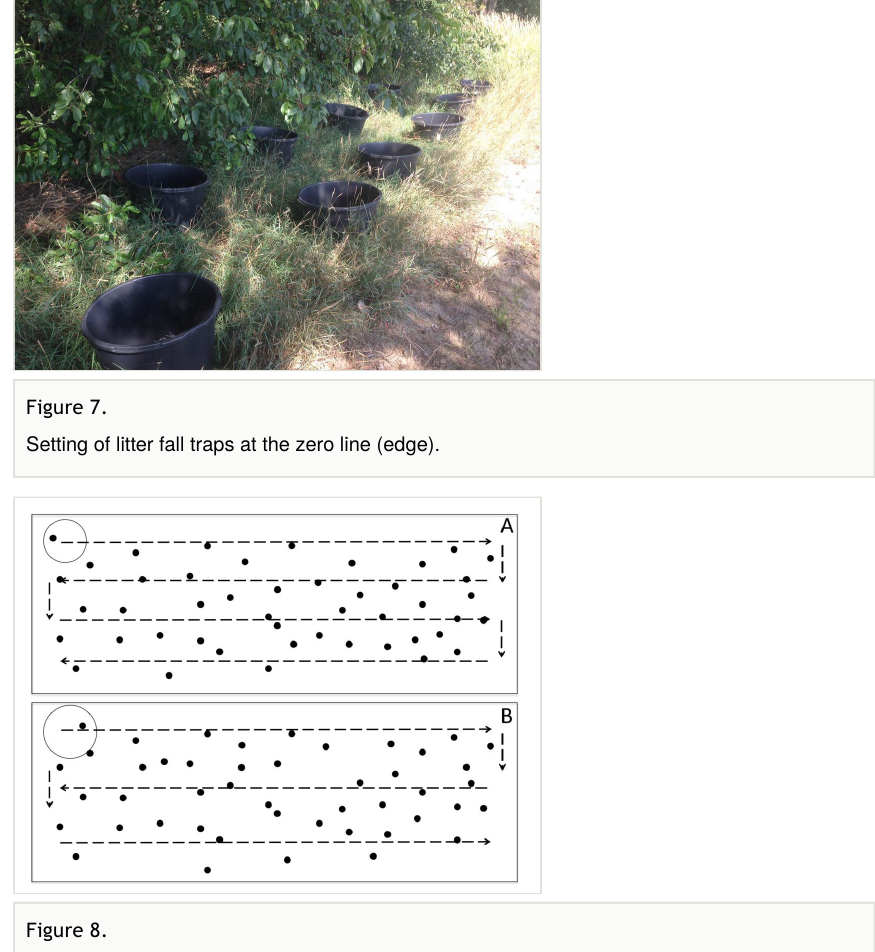
Design for tree inventory with the dots as examplary trees, the arrows as walking direction during measurements and the circles as the range of counting the trees with 5 m range in A and 7 m range in